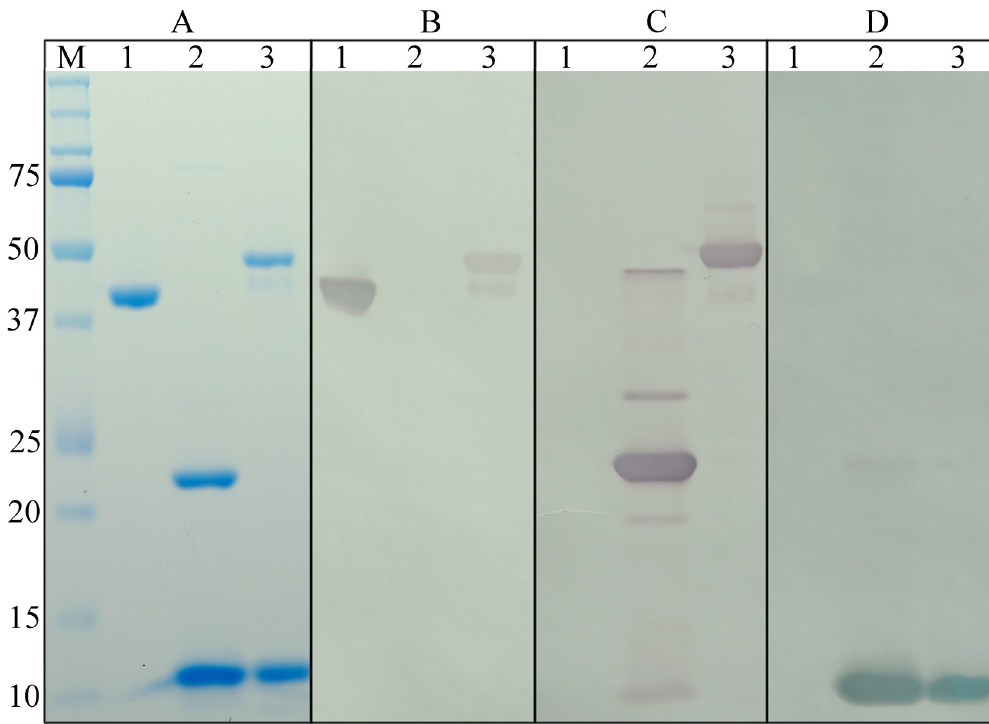
Fig 2. Characterization of the protein components of the dscCfaE-CTA2/CTB chimera. Recombinant dscCfaE (Lane 1), CT (Lane 2) and dscCfaE-CTA2/CTB (Lane 3) separated by SDS-PAGE (A) and immunodetected with anti-CfaE (B), anti- CTA (C), or anti-CTB polyclonal rabbit serum (D). The molecular weight marker (Bio-Rad Precision Plus Protein ™ Standards) is shown in Lane M.